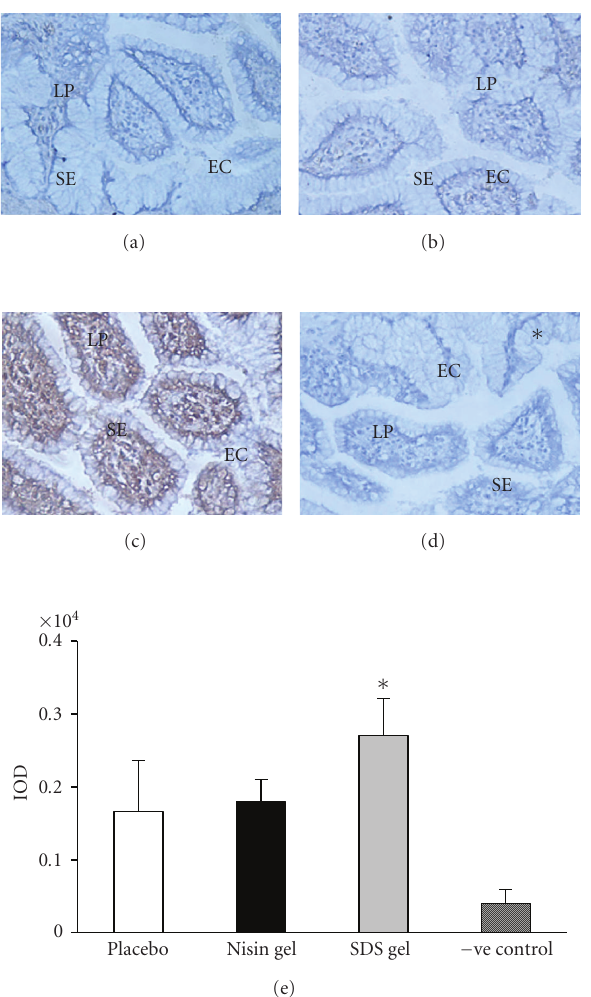
Figure 4: Immunohistochemical localization of IL-4 in the CVE after intravaginal application of nisin (15.15mM in 2mL of 1% polycarbophil gel) (b), SDS (56 μ M in 2mL of 1% polycarbophil gel) (c) and 2 mL of 1% polycarbophil gel (a) for 14 consecutive days. To rule out the nonspecific binding, sections were incubated in preimmune sera instead of primary antibody and considered as negative control (d). Semi-quantitative comparison by measuring integrated optical density (IOD) of immunoreactive IL-4 in treated and placebo is shown (e). The IOD in each area was calculated for the brown color immunoprecipitates. Each IOD value measured is the mean ± SD of six observations obtained from three independent samples. (Mag X 20) (EC = epithelial cells, SE = Squamous epithelium, LP = lamina propria), ( ∗ = value is statistically significant at P < . 05).